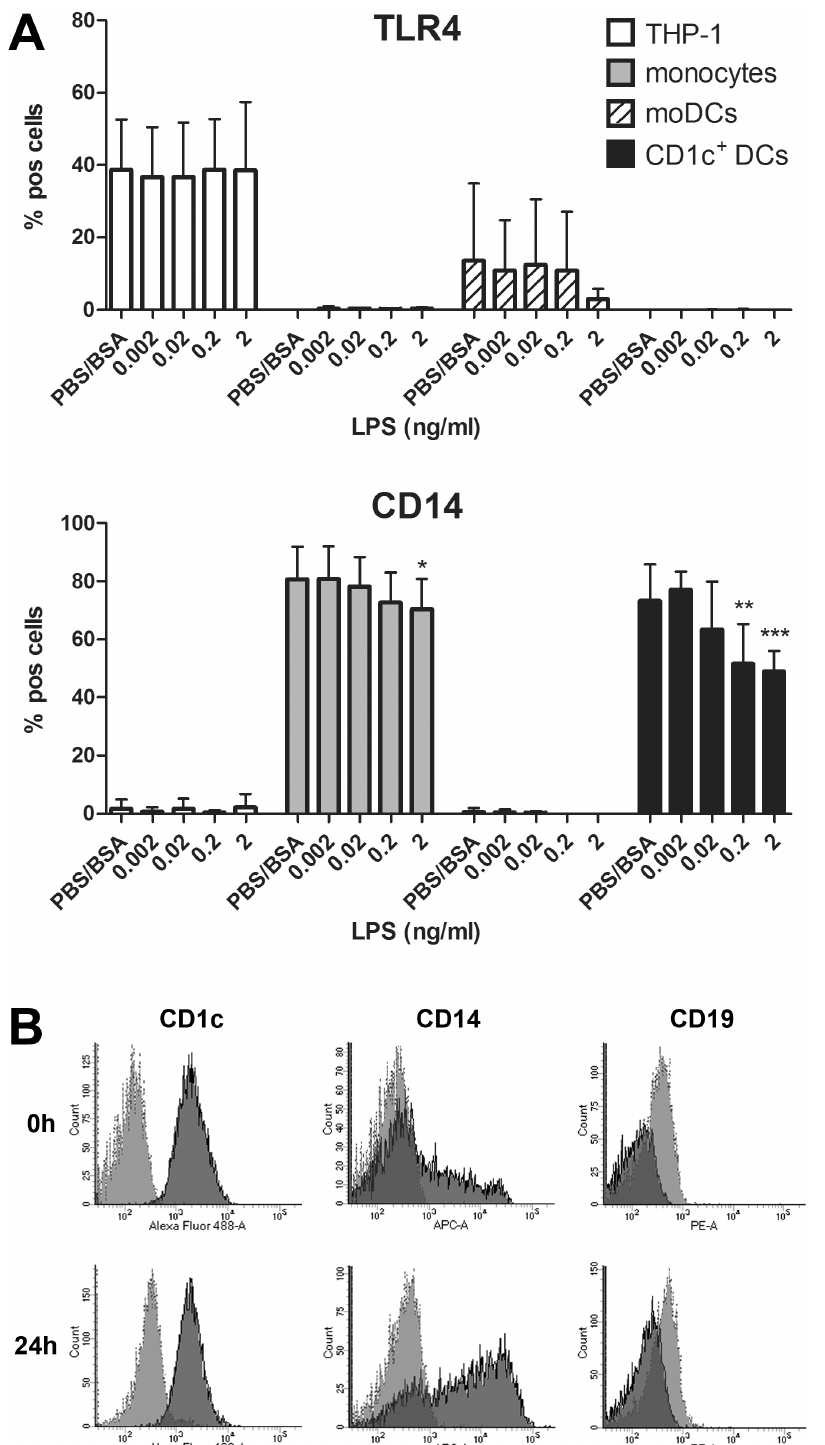
Figure 5. Endotoxin sensitivity correlates with CD14 expression. A Expression of TLR4 and CD14 on different human immune cells. Cells were plated and induced as described in Figure 3. After 24 h, cells were stained for the expression of TLR4 and CD14 and analysed by flow cytometry. Results show the